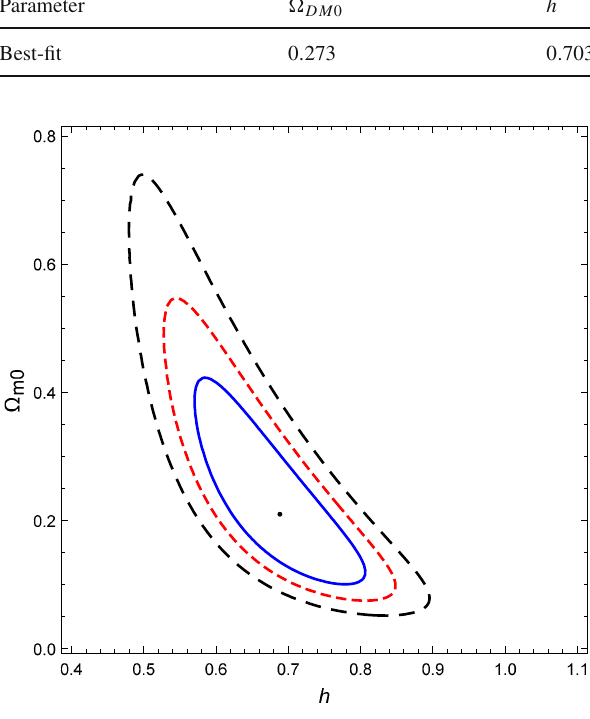
= 0 . 618 or in term of redshift acceleration begin t acc = a (cid:10) 2 z ace = 0 . 617. and the present values of EoS is ω D 0 = − 0 .